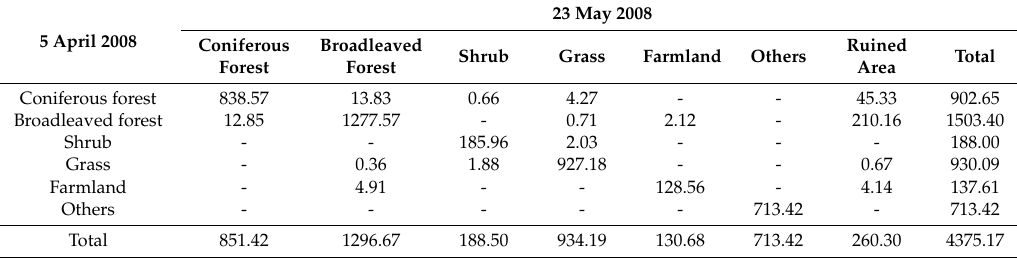
Table 3. Transfer matrix of each vegetation type before and after the earthquake.